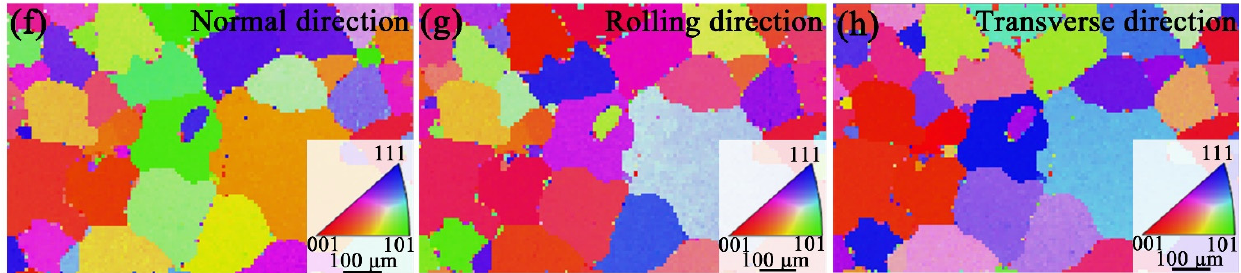
Figure 2. ( a ) XRD diffraction patterns and ( b ) Lattice parameter a of the as-prepared Ce x Fe 3 CoSb 12 (x = 0 to 1.5). ( c ) HAADF image with an inserted 2 × 2 × 2 supper cell model, ( d ) SAED pattern in ( c ) and ( e ) Inverse pole figure (IPF) maps in CeFe 3 CoSb 12 . The EBSD IPF maps in ( f ) normal direction, ( g ) rolling direction and ( h ) transverse direction of the Ce 1.25 Fe 3 CoSb 12 .